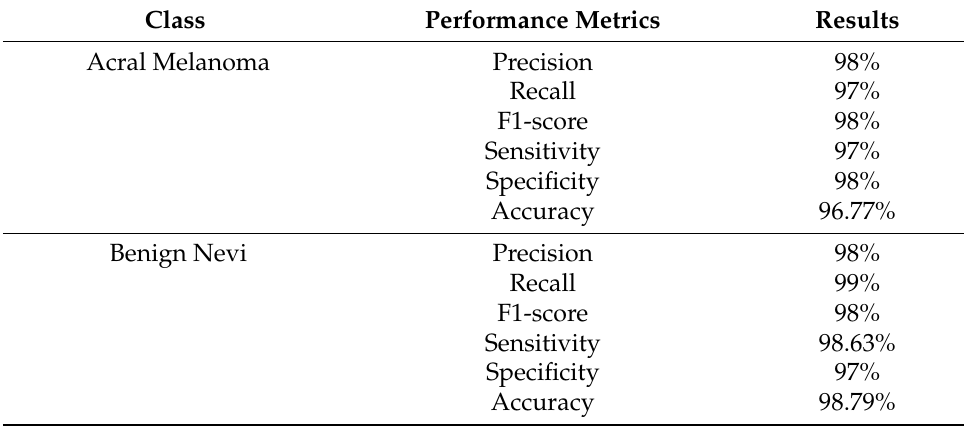
Table 5. Class-wise performance of the proposed